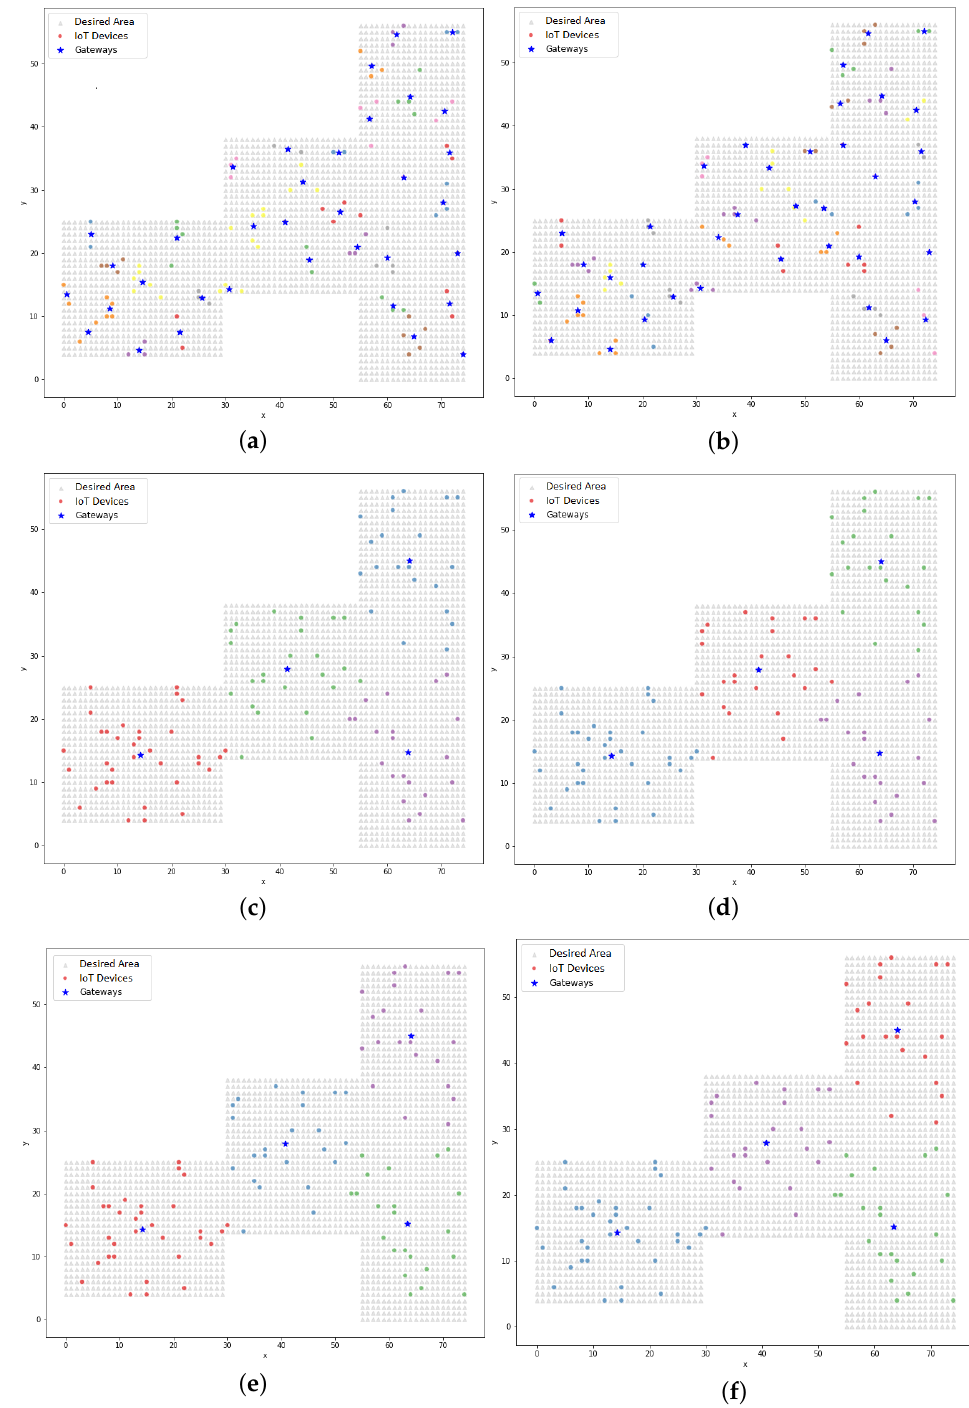
Figure 12. the clustering of IoT devices and their respective gateways using the PSO model (hybrid approach): ( a ) BLE technology with 100 devices and 35 gateways; ( b ) BLE technology with 300 devices and 37 gateways; ( c ) Wi-Fi technology with 100 devices and 4 gateways; ( d ) Wi-Fi technology with 300 devices and 10 gateways; ( e ) LoRa technology with 100 devices and 4 gateways; ( f ) LoRa technology with 300 devices and 10